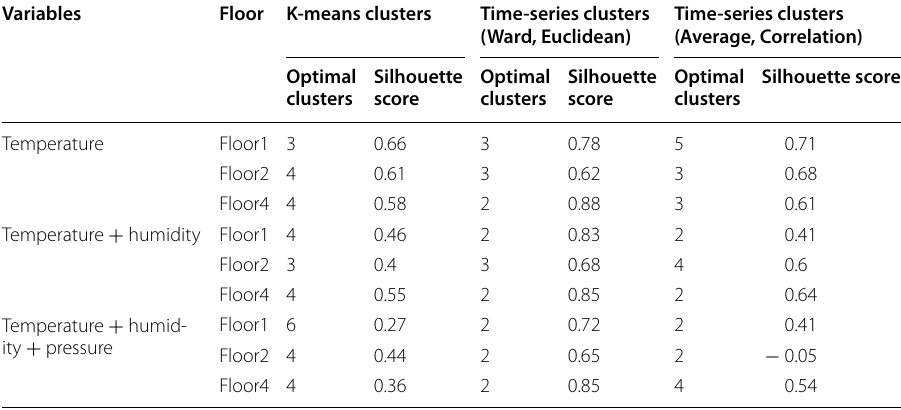
Table 4 Optimal number of clusters and silhouette score for each clustering method